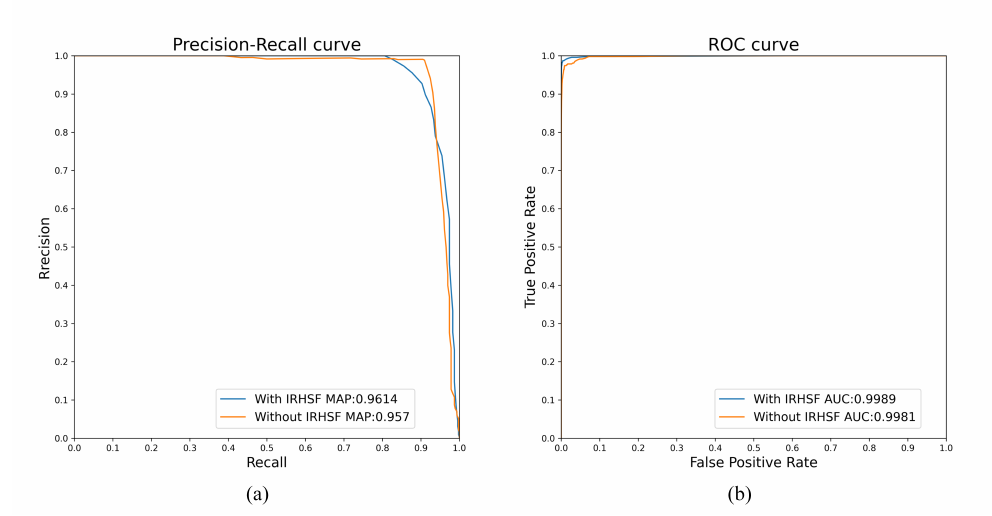
Figure 12. Influence of IRHSF on AUC and mAP values. ( a ) PR curve, ( b ) ROC curve.